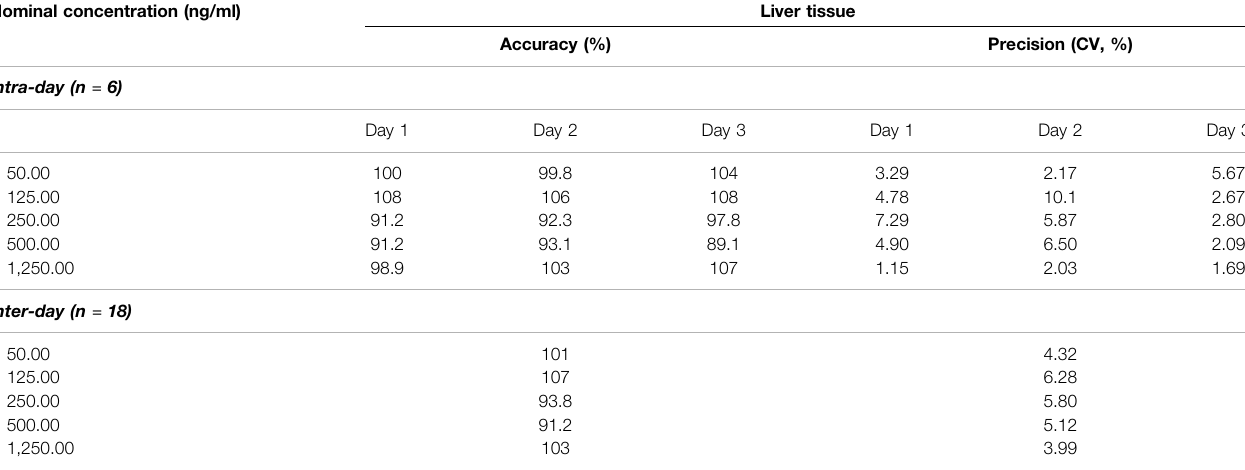
TABLE 1 | Accuracy and precision intra- and inter-day of ICG in murine tissue samples. Nominal concentration (ng/ml)